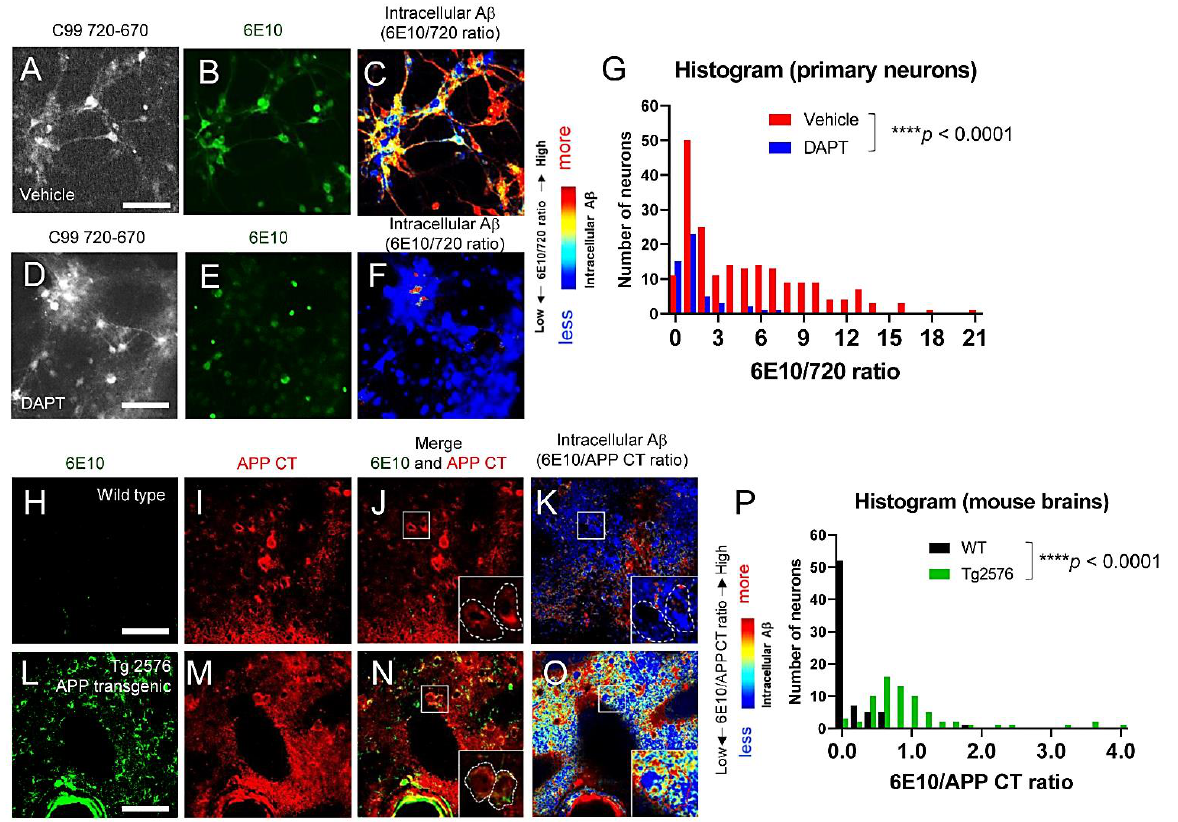
Figure 3. Cell-to-cell heterogeneity in intracellular A β levels. ( A – G ) Neurons expressing the C99 720-670 biosensor were treated either with 1 µ M DAPT ( D – F ) or vehicle control ( A – C ) for 16 h, followed by staining with Alexa488-6E10. The pseudo-color images of Alexa488-6E10 over C99 720-670 emission ratio (red = more A β ) ( C , F ) and quantification ( G ) illustrate that intracellular A β levels are distinct among neurons (50 neurons, **** p < 0 .0001). Scale bar: 50 μm. ( H – P ) Brain sections from Tg2576 APP transgenic ( L – O ) or wild-type control mice ( H – K ) were stained with Alexa488-6E10 and Cy3-APP C-term antibodies. As expected, the Alexa488-6E10 over Cy3-APP C-term emission ratio is significantly higher in Tg2576 than in wild-type brain sections, and individual cells in the Tg2576 brain exhibit distinct levels of Alexa488-6E10/Cy3-APP CT ratio (70 cells from 3 independent mice, **** p < 0.0001) ( P ). Scale bar: 40 μm.